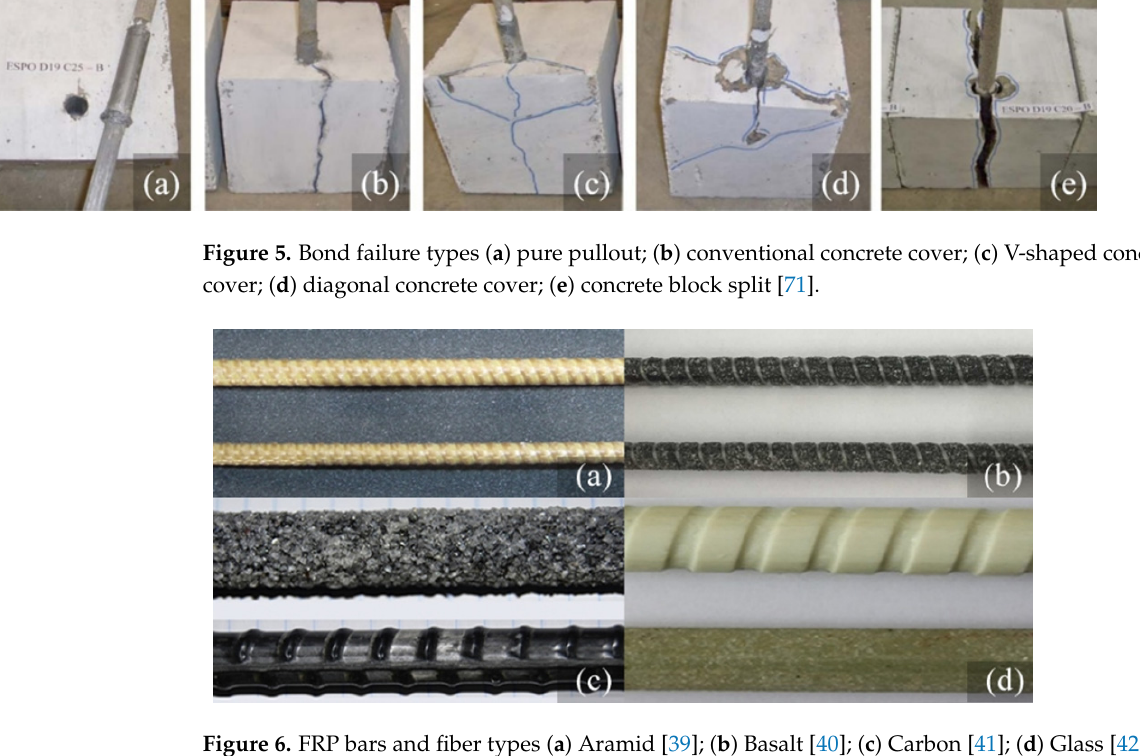
Table 5. Studies on the influence of reinforcement location on FRP–concrete bond